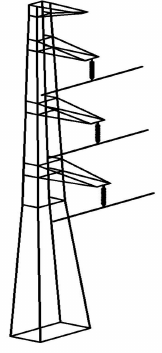
Figure 7. The 3-D simulation